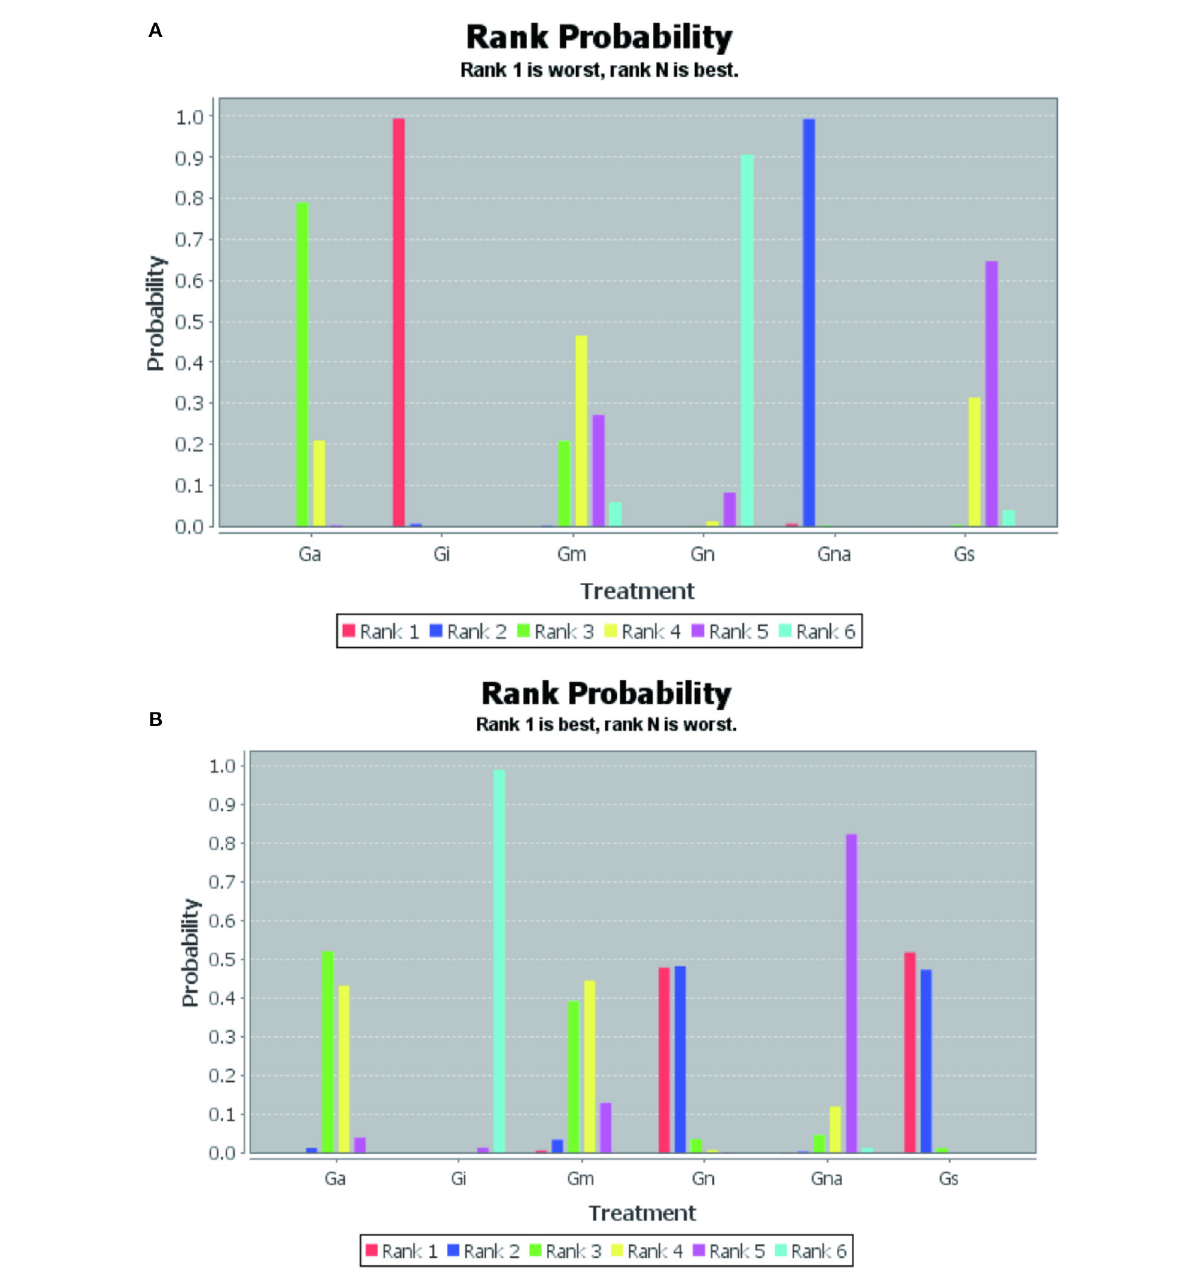
FIGURE3 Rank probability of interventions. Escape latency (A) , Number of crossings (B). Gn, Normal group; Gs, Sham-operated group; Gi, Impaired group; Ga, acupuncture group; Gna, Non-acupoint group; Gm, Medicine